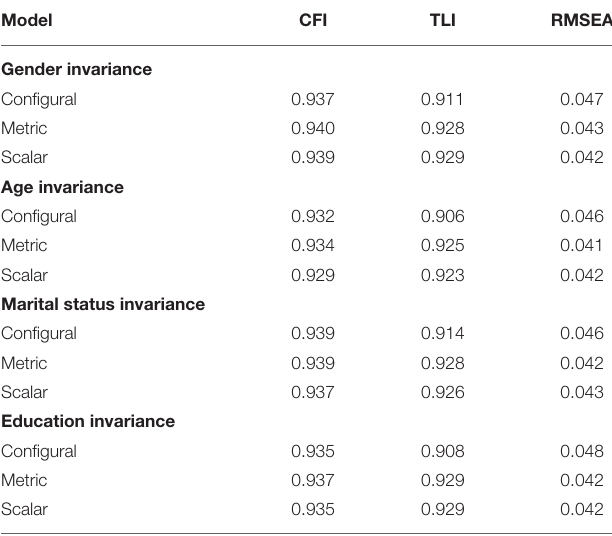
TABLE 4 | Goodness of fit for gender, age, education, and marital status measurement invariance ESEM model based on the T1 and T2 stacked